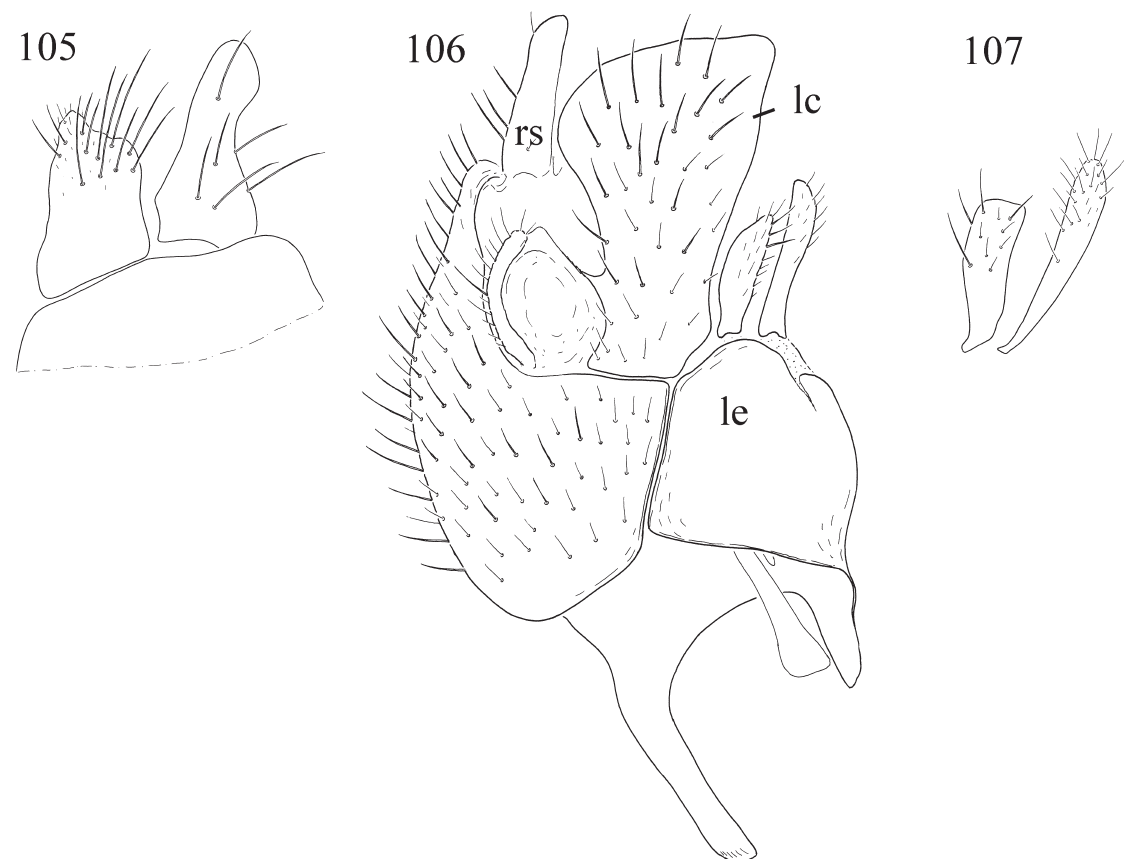
Figs 105-107. Drapetis pantai sp. nov., ♂ terminalia. 105 . right surstylus, dorsal view. 106 . epandrium and cerci, dorsal view. 107 . left surstylus, lateral